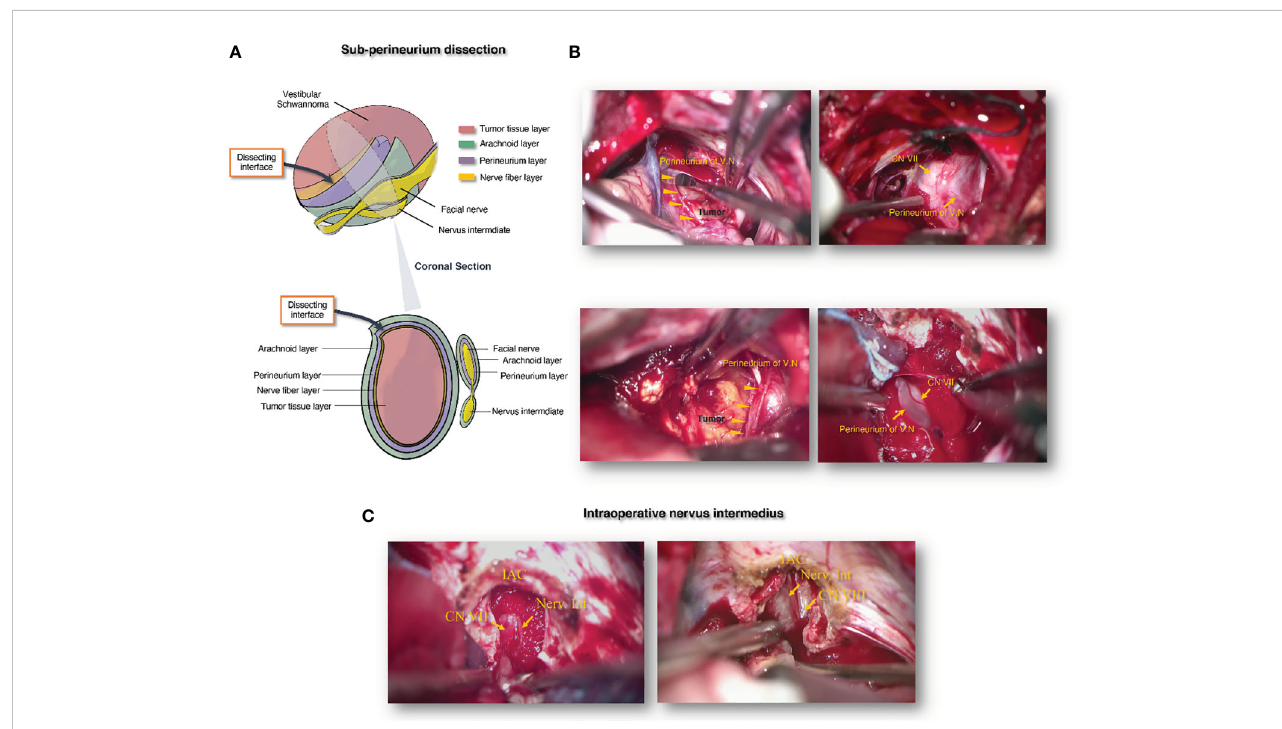
FIGURE 2 The schematic diagram illustrating the principle of sub-perineurium dissection in vestibular schwannoma microsurgery for neurofunction preservation. (A) Schematic diagram of sub-perineurium dissection in vestibular schwannoma microsurgery. (B) Intraoperative images of sub-perineurium dissection in vestibular schwannoma microsurgery. (C) Intraoperative images of nervus intermedius in vestibular schwannoma microsurgery after IAC management. IAC, internal acoustic canal; CN VII, the 7th cranial nerve; CN VIII: the 8th cranial nerves; Nerv.Int, nervus